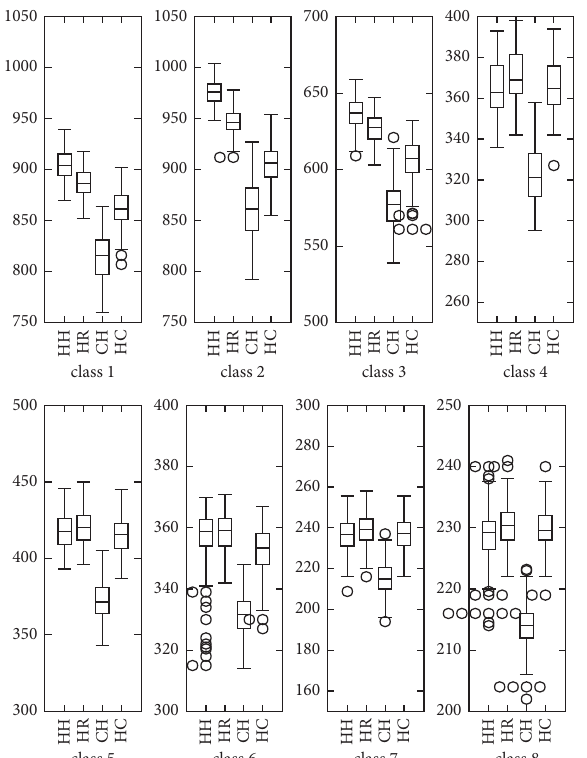
Figure 4: Boxplots of makespans of schedules (minimum, lower quartile, median, upper quartile, maximum, and outliers) returned by the LS algorithms for the SCP1 classes nos. 1, 2, 3, and 4 (top fgures) and classes nos. 5, 6, 7, and 8 (bottom fgures) with cov �